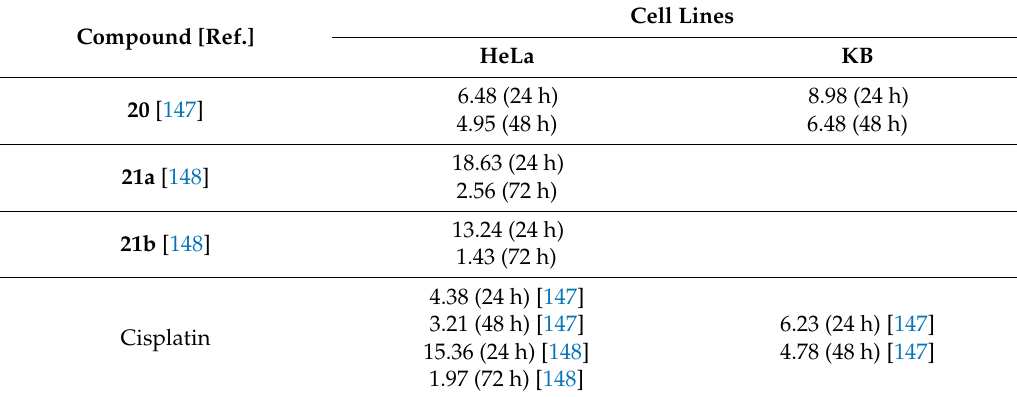
Table 5. IC 50 values ( µ M) for zinc complexes 20 , 21a , b and reference cisplatin against HeLa and KB tumor cell lines after an incubation time of 24, 48 or 72 h.